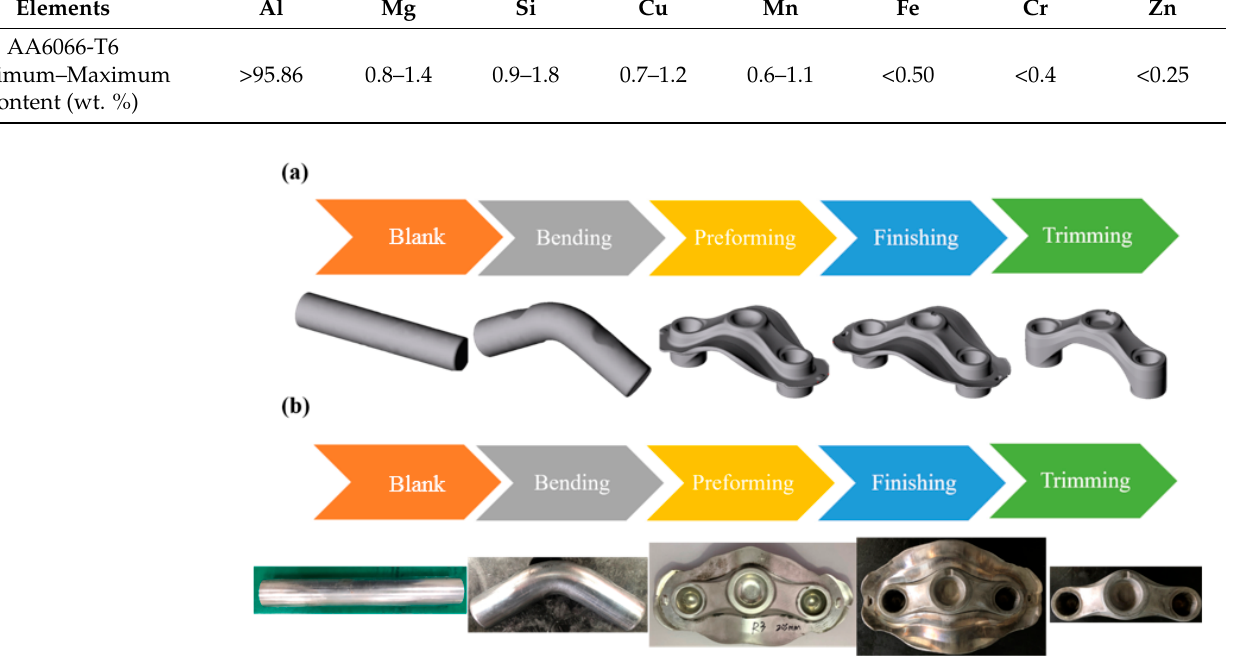
Figure 2. Process flow chart. ( a ) FEM model; ( b ) actual forging.